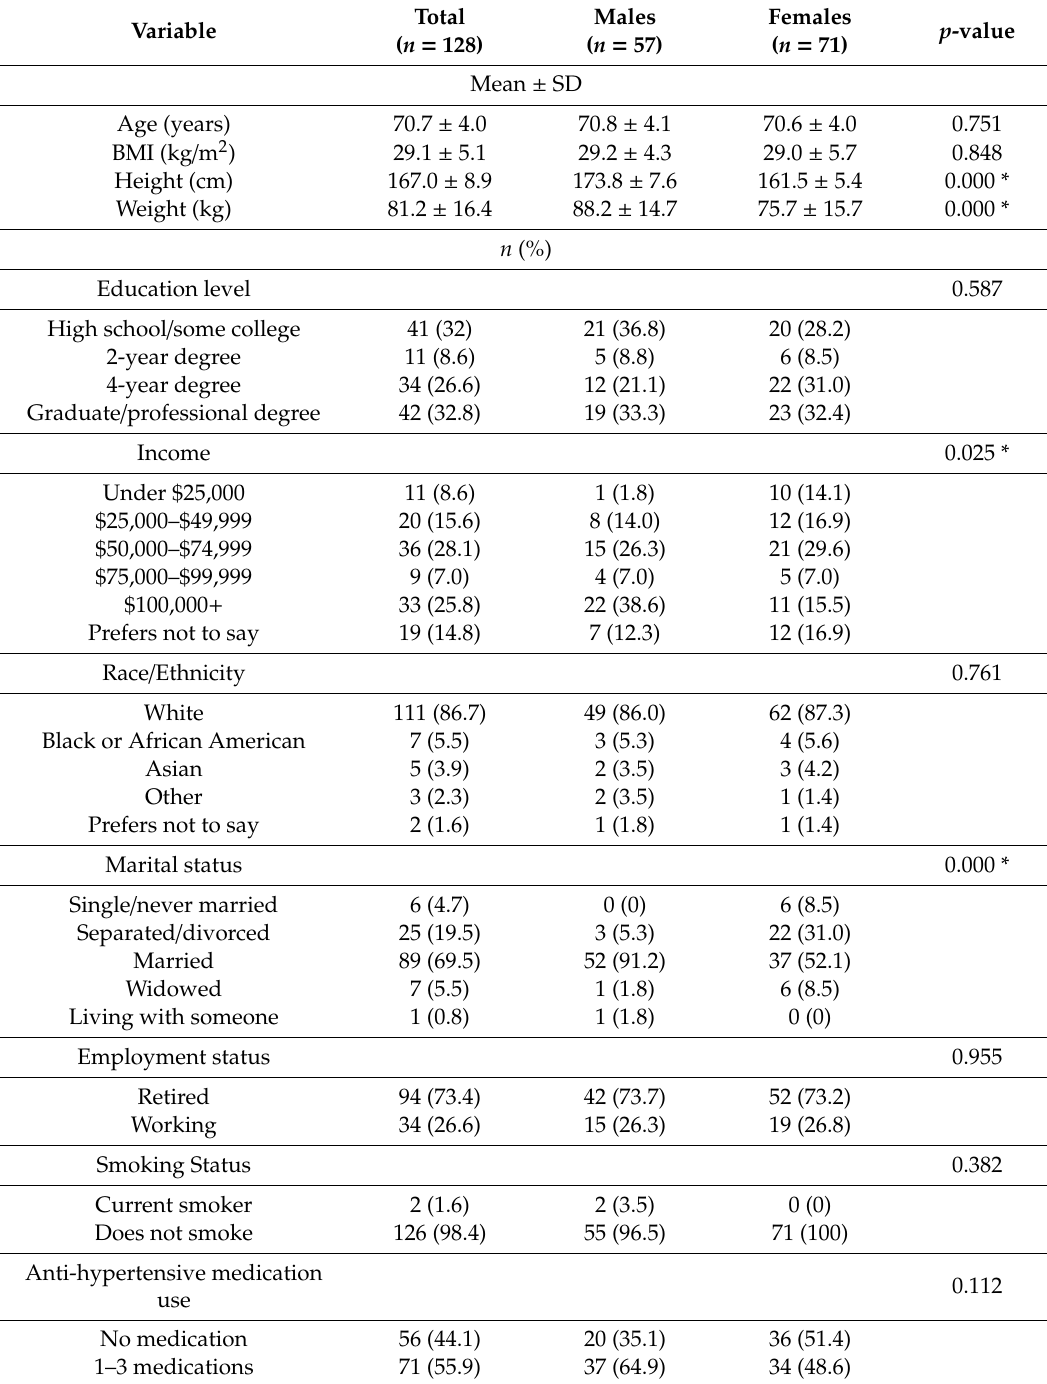
Table 1. Characteristics of the study